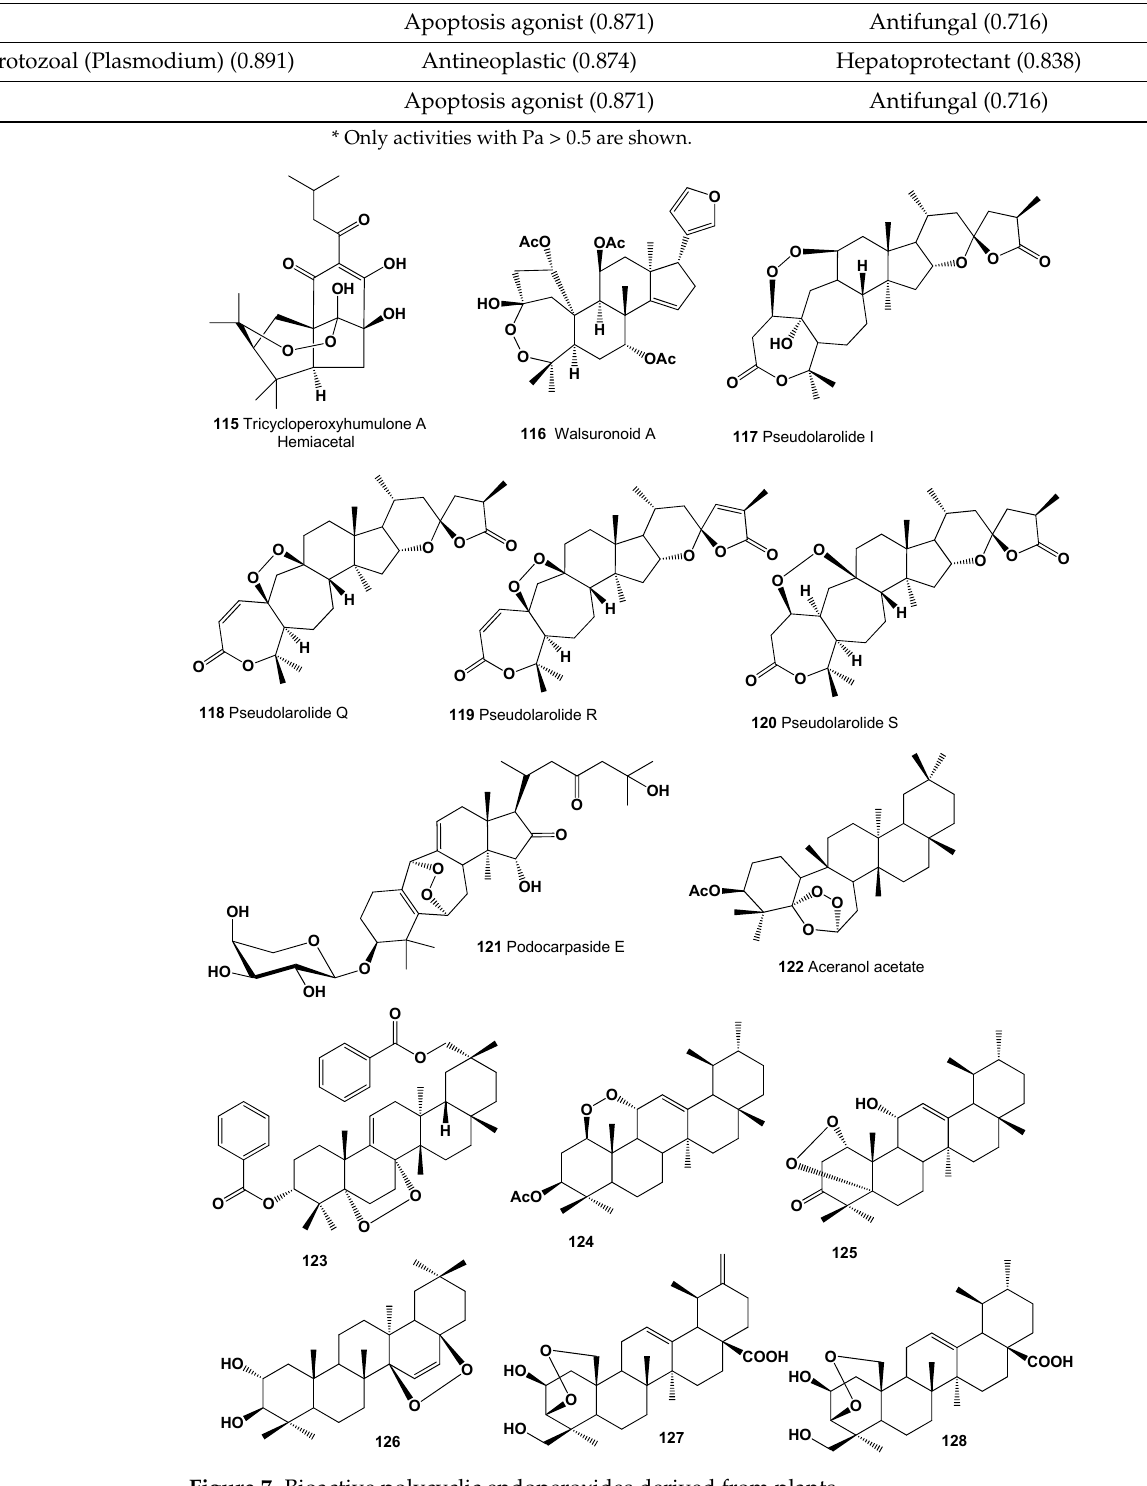
Figure 7. Bioactive polycyclic endoperoxides derived from plants. A cytotoxic peroxytriterpene dilactone called pseudolarolide I ( 117 ) has been isolated from the seeds of Pseudolarix kaempferi [205], and the leaves of P. kaemferi contains three triterpene peroxides, pseudolarolides Q ( 118 ), R ( 119 ), and S ( 120 ) [206]. An unusual gly- coside, 3 β ,15 α ,25-trihydroxy-16,23-dioxo-6 α ,19 α -epidioxy-9,10-seco-9,19-cyclolanost-5 (10),9(11)-diene 3-O- α -1-arabinopyranoside called podocarpaside E ( 121 ), was isolated from the roots of Actaea podocarpa [207]. A triterpene, 5 α ,6 α -epidioxy-5 β ,6 β -epoxy-9,13-dimethyl-25,26-dinoroleanan-3 β -ol acetate, called aceranol acetate ( 122 ), which shows anti-inflammatory activity, was iso- lated from the stems and leaves of Acer mandshuricum [208]. The isolated compound also